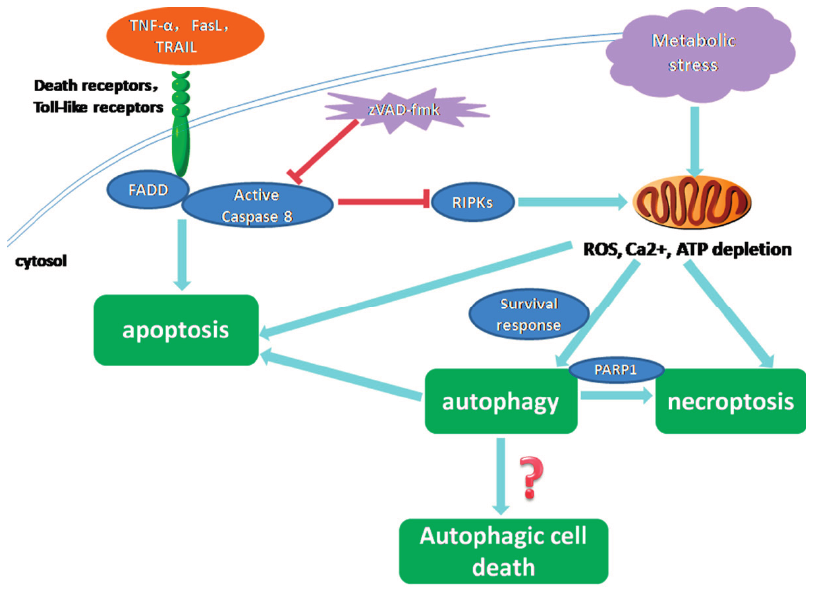
Figure 2. Interactions among apoptosis, autophagy and necroptosis under metabolic